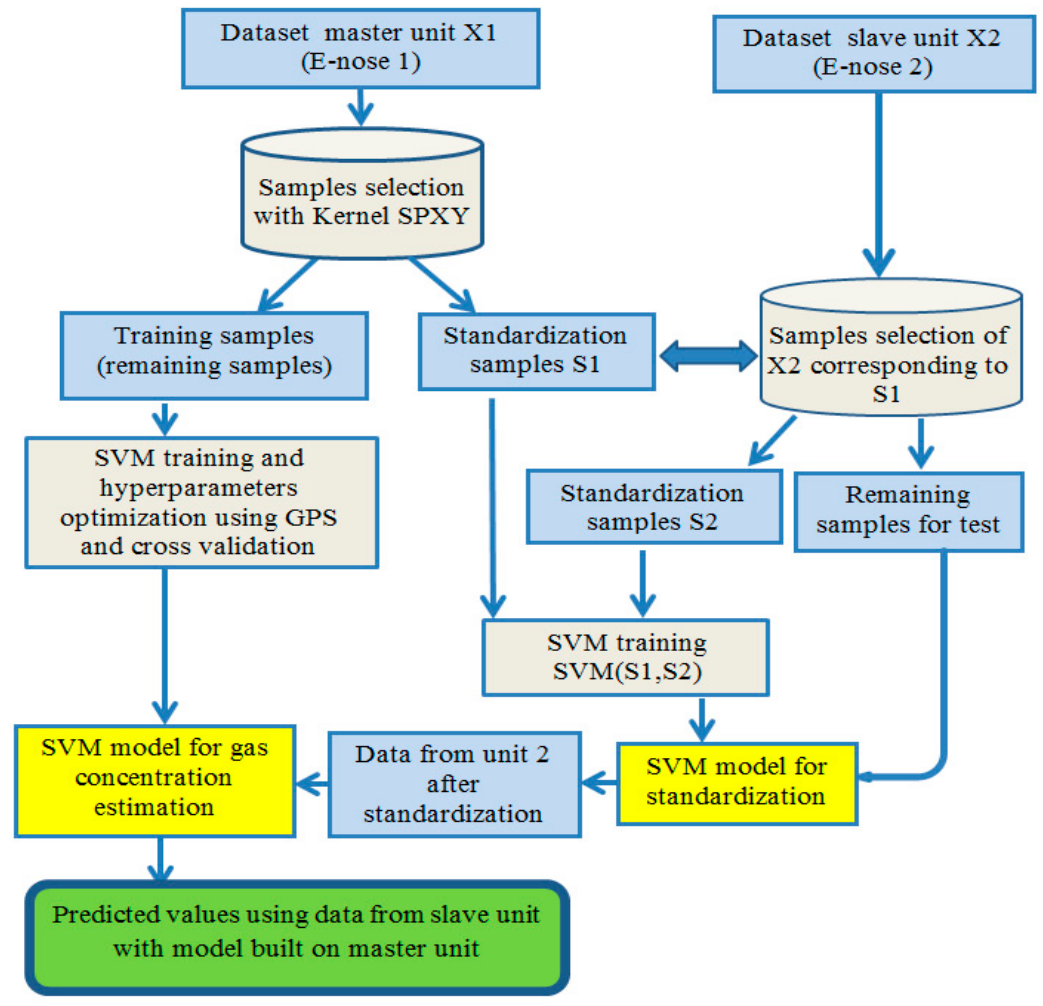
Figure 2. Illustration of the calibration transfer procedure between two identical electronic noses using support vector machine regression (SVM).